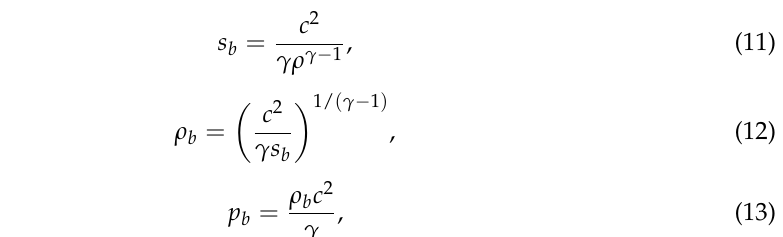
Table 1. Discretization schemes of governing equations. Equations Discretization Method Pressure Second-order Momentum Bounded central differencing Energy Second-order upwind Transient formulation Second-order